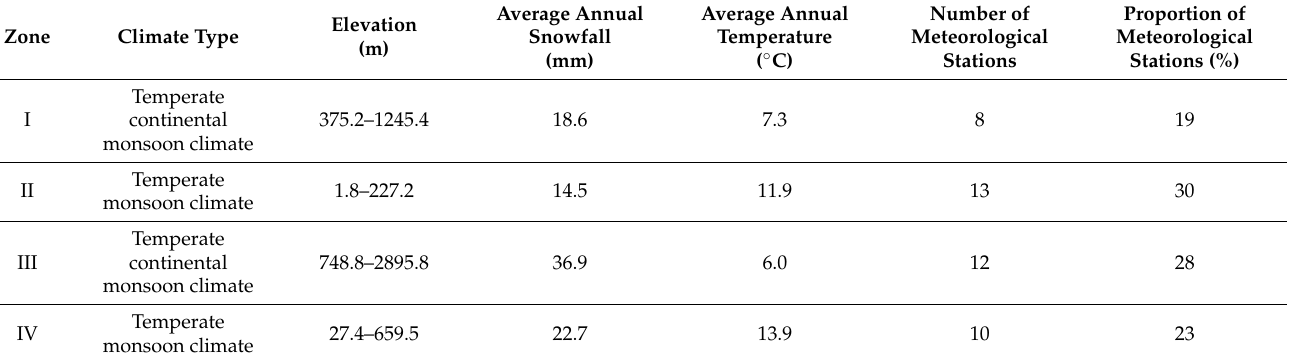
Table 1. Basic information for the zone partitioning